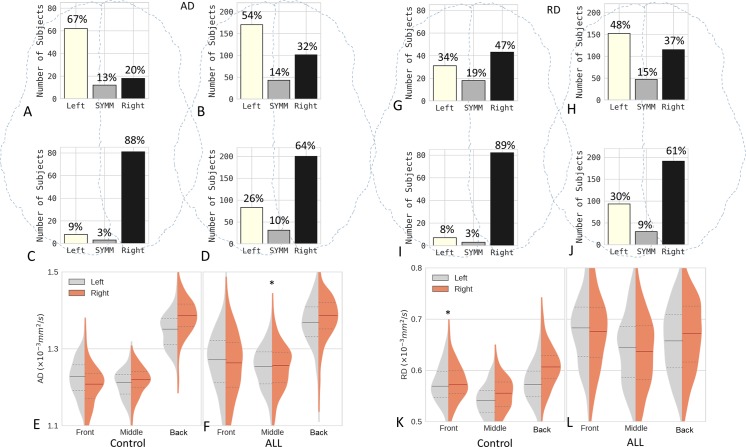
Microstructural asymmetry in the brain.(A–F) Axon-related asymmetry. (G–L) Myelin-related asymmetry. (A, C) The number of subjects with significantly greater axial diffusivity (AD) on one side or no significant difference (SYMM) between the two sides of the front (A) and back (C) brain in the control group (92 subjects in total). (B, D) The corresponding results for the ALL group (314 subjects in total). (G–J) The corresponding results for radial diffusivity (RD). (E, F) Violin plots of the average AD in each ROI for the subjects in each group, showing the kernel density estimation for each side, with bars representing the first quartile, median, and third quartile. (K, L) The corresponding results for RD. The medians on the left and right (E, F, K, L) were significantly different except for those at positions marked with an asterisk (*), which indicates no significance. ALL, acute lymphoblastic leukemia.